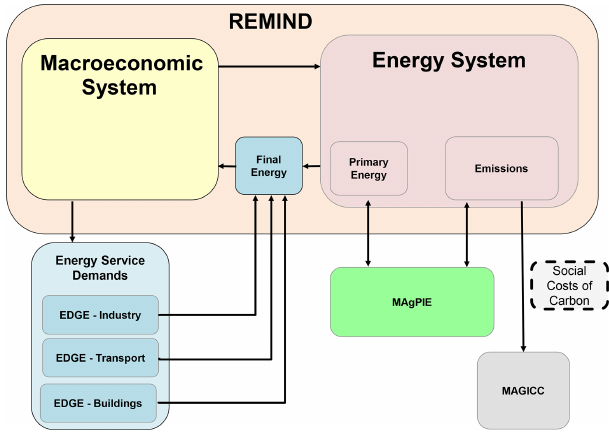
Figure 3. REMIND and possible links to other